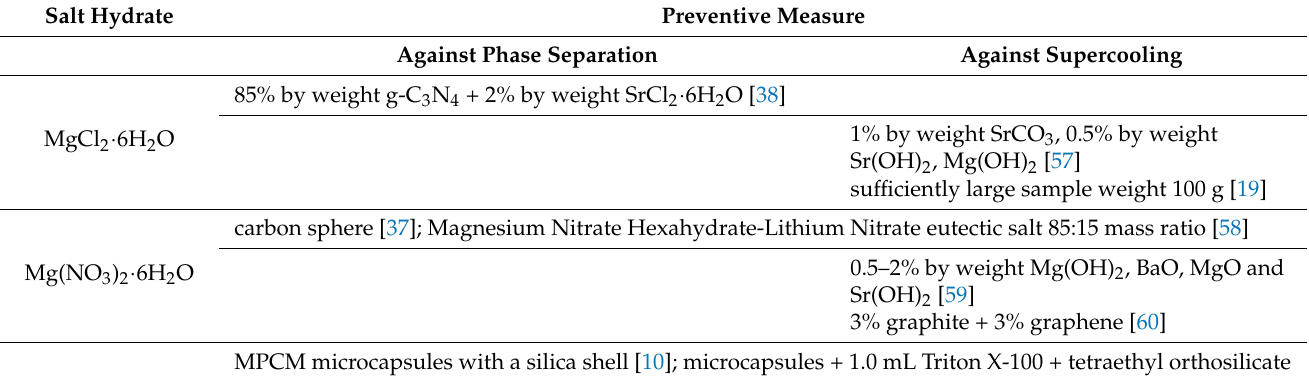
Table 3. Supercooling and the phase segregation of salt hydrates—preventive